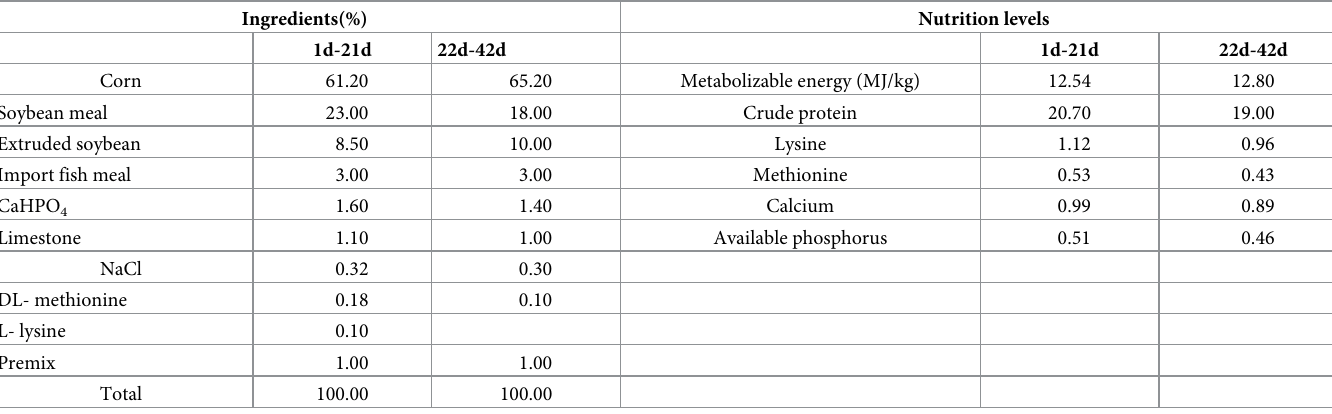
Table 1. Raw material composition and nutritional level of basic dietary (air-dry basis).